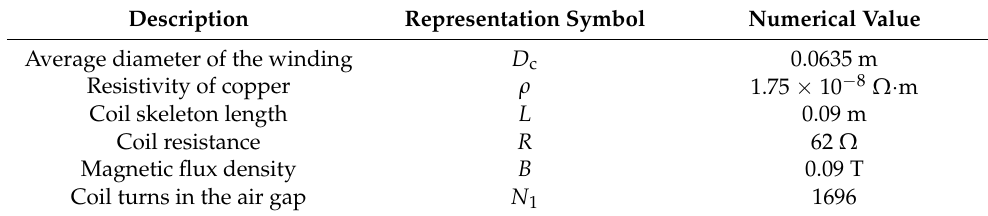
Table 5. Parameters of the simulated